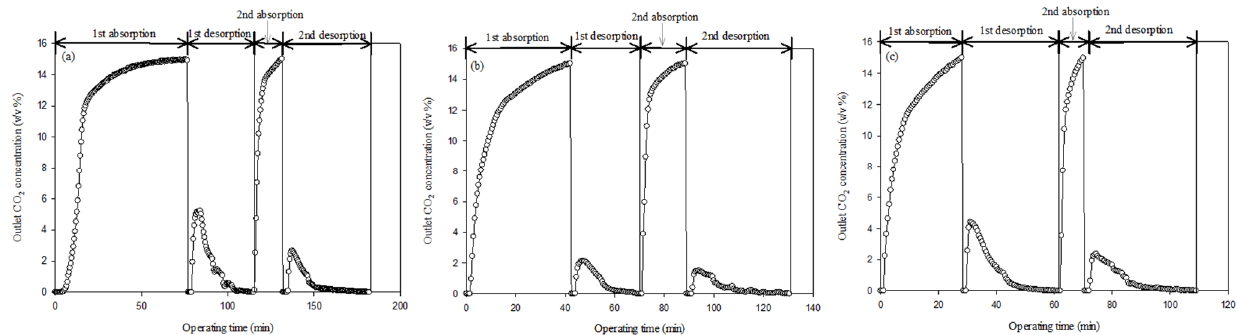
Figure 2. Results of CO 2 loading at 5 wt % for each amine by (re-)absorption and (re-)desorption. First desorption and second absorption experiments as checked by the residual CO 2 remaining after reaction with metal ions in concentrated seawater: ( a ) monoethanolamine (MEA) solution, ( b ) di-ethanolamine (DEA) solution, and ( c ) methyl-diethanolamine (MDEA) solution.